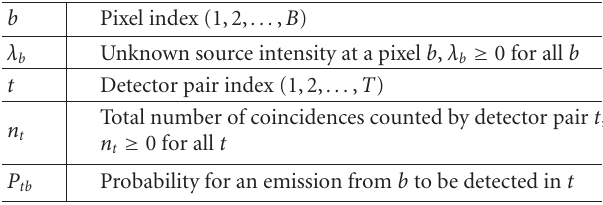
Table 1: Notations used throughout this